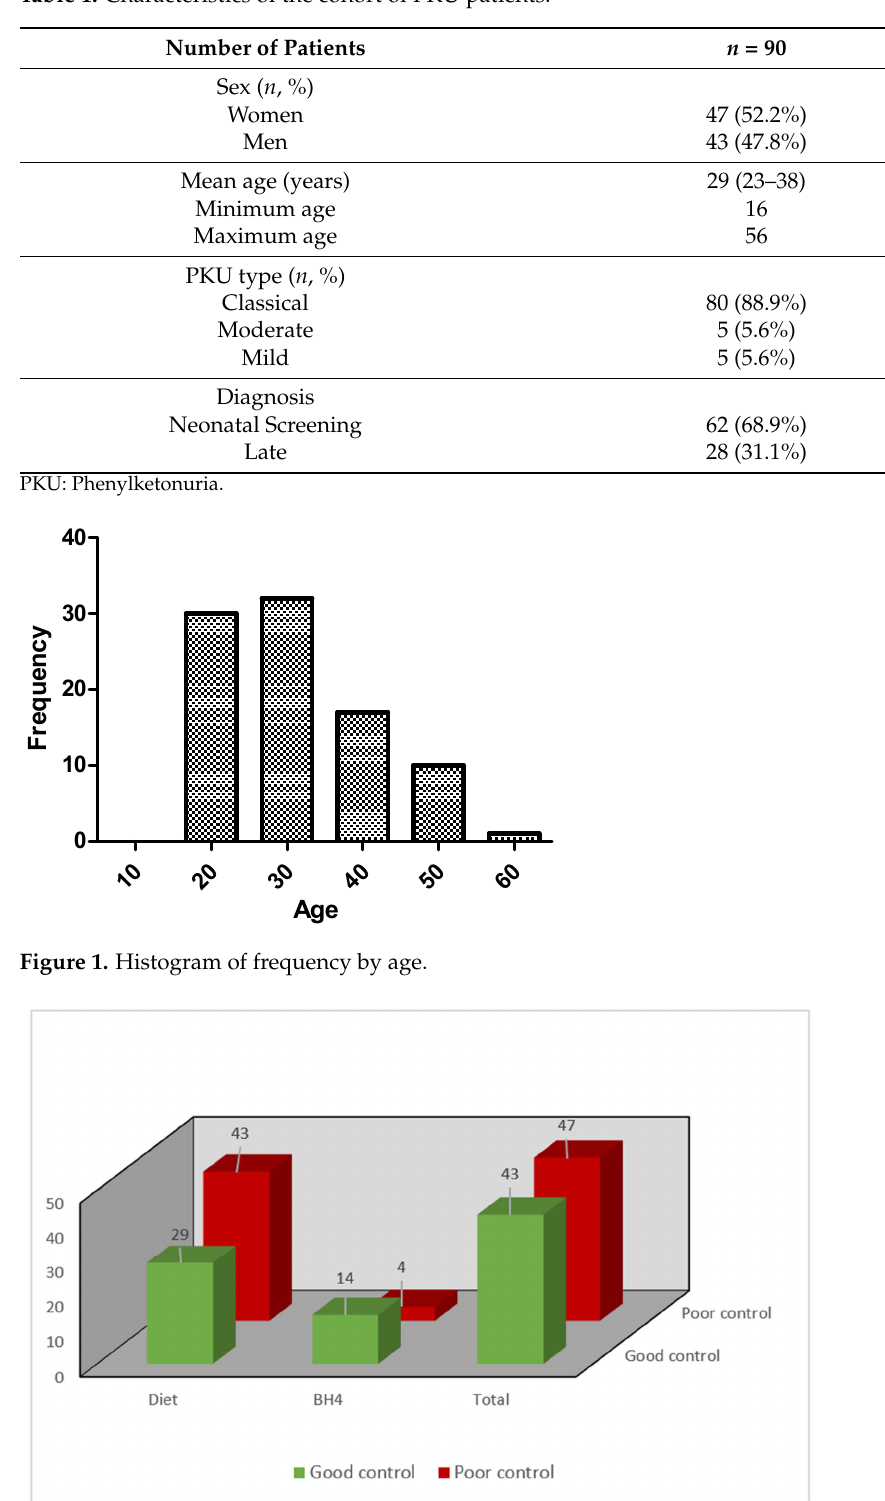
Table 1. Characteristics of the cohort of PKU patients.